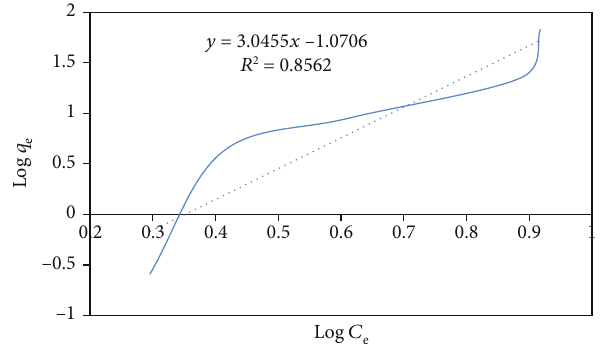
versus log C . e e